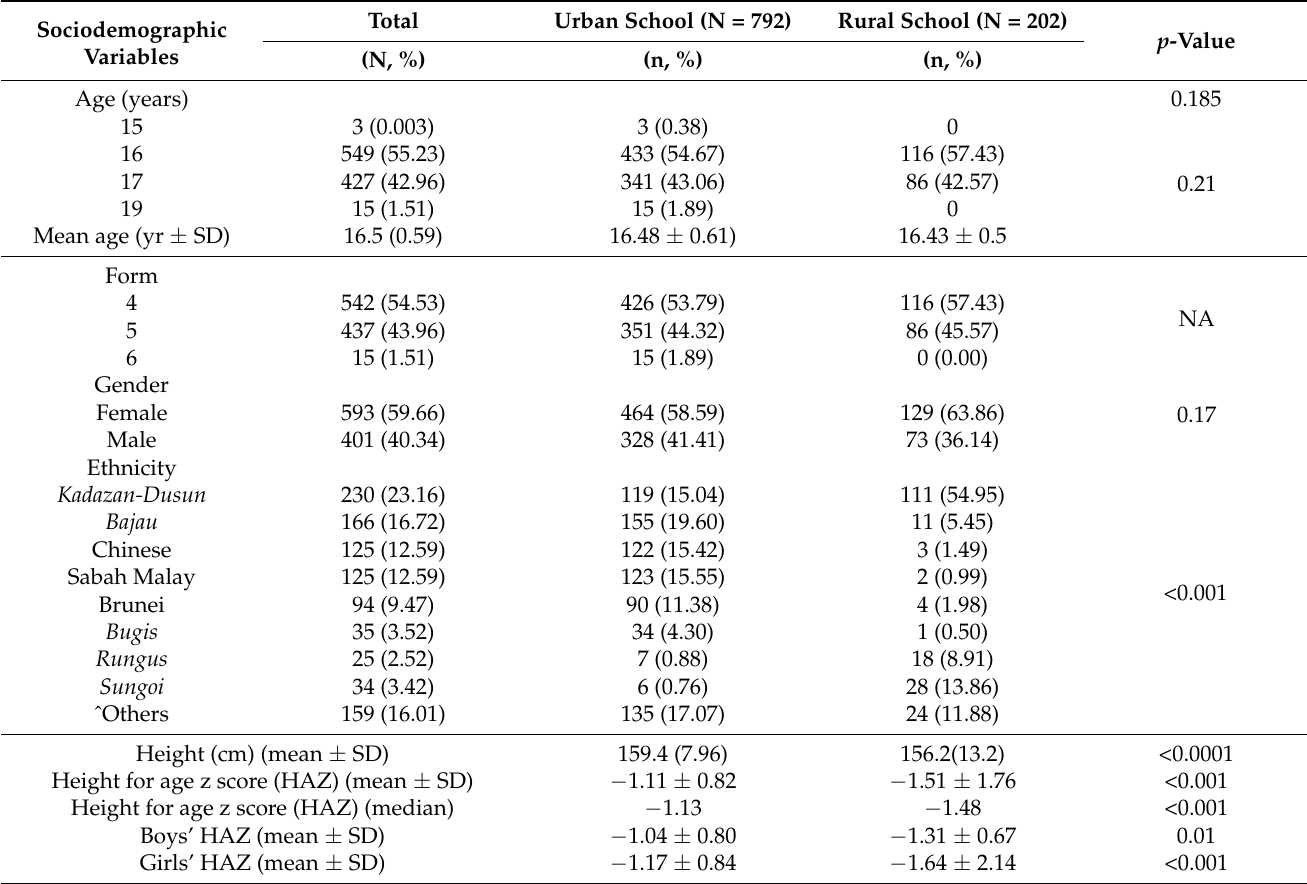
Table 1. Sociodemographic characteristics of secondary school students (N =